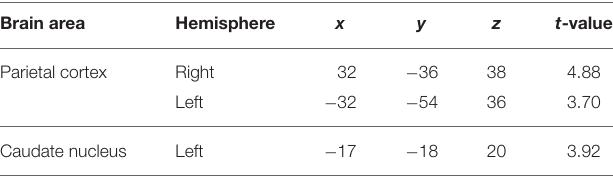
Table 2A | Brain areas whose activity increased as a function of memory load.